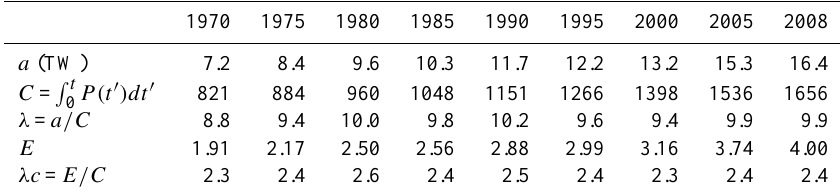
Table 1. Measured values for the global rate of energy consumption a (TW), global wealth C (trillion 1990US$), CO 2 emissions rates E (ppmv atmospheric equivalentyr − 1 ), the hypothesized constant parameter λ (mW per 1990US$) and λc (ppmvyr − 1 per 10 15 1990US$) where c = E/a